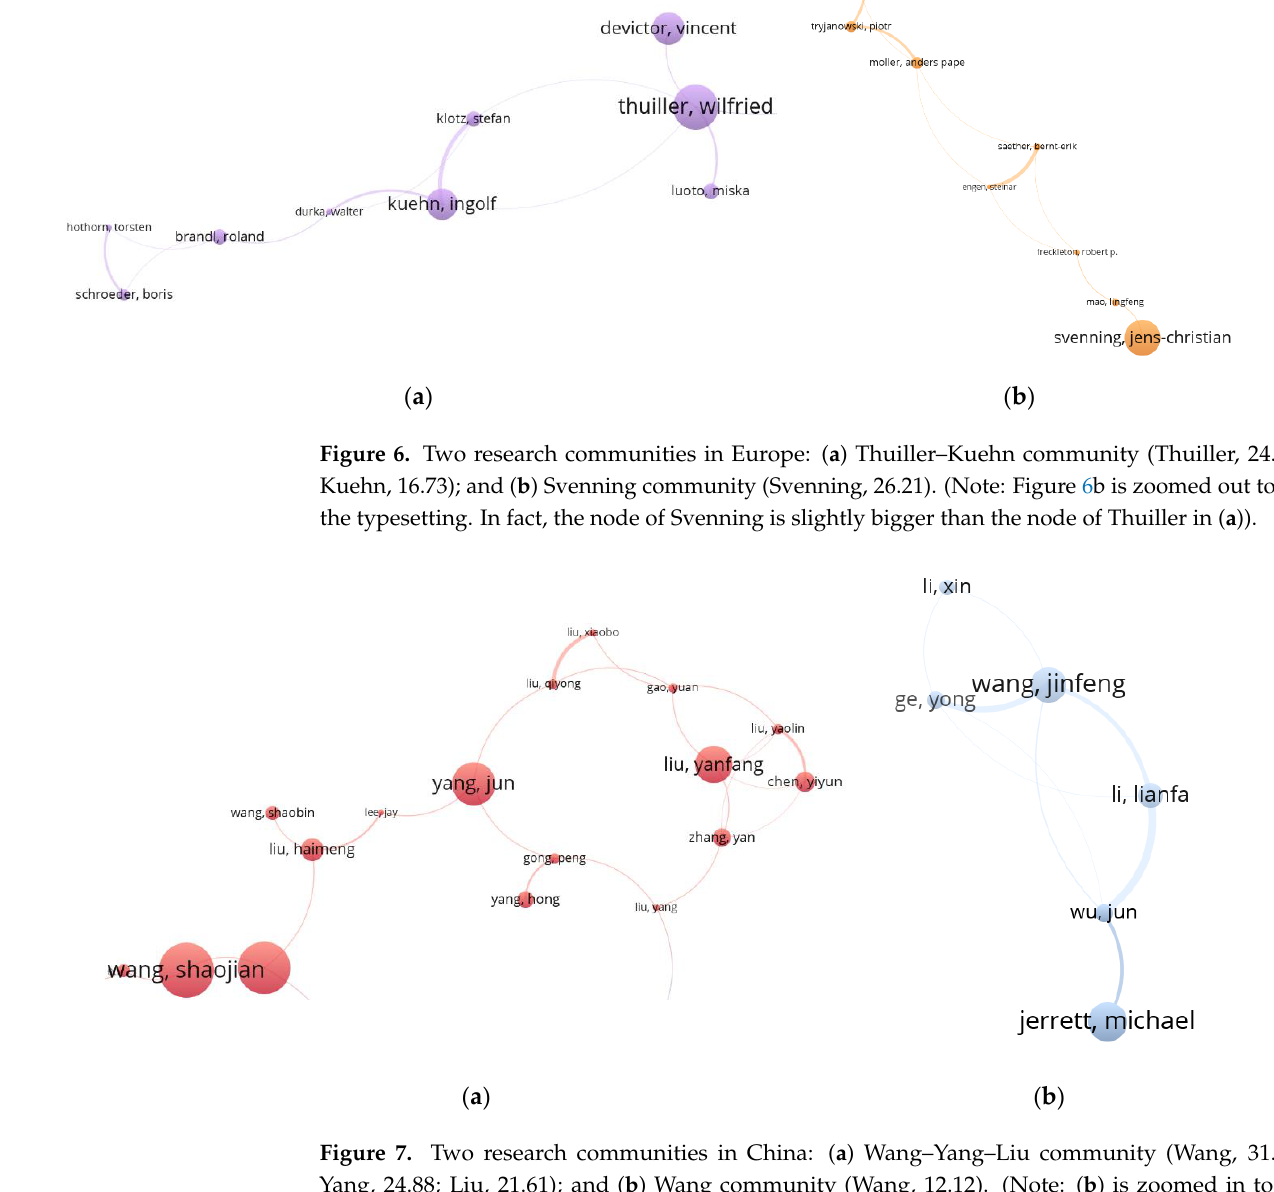
Figure 5. Five research communities in northern America: ( a ) Epperson community (Epperson, 17.69); ( b ) Legendre – Fortin community (Legendre, 50.14; Fortin, 24.72); ( c ) Jetz community (Jetz, 20.55); ( d ) Peres Neto – Dray community (Peres Neto, 30.11; Dray, 25.38); and ( e ) Griffith commu- nity (Griffith, 30.43).